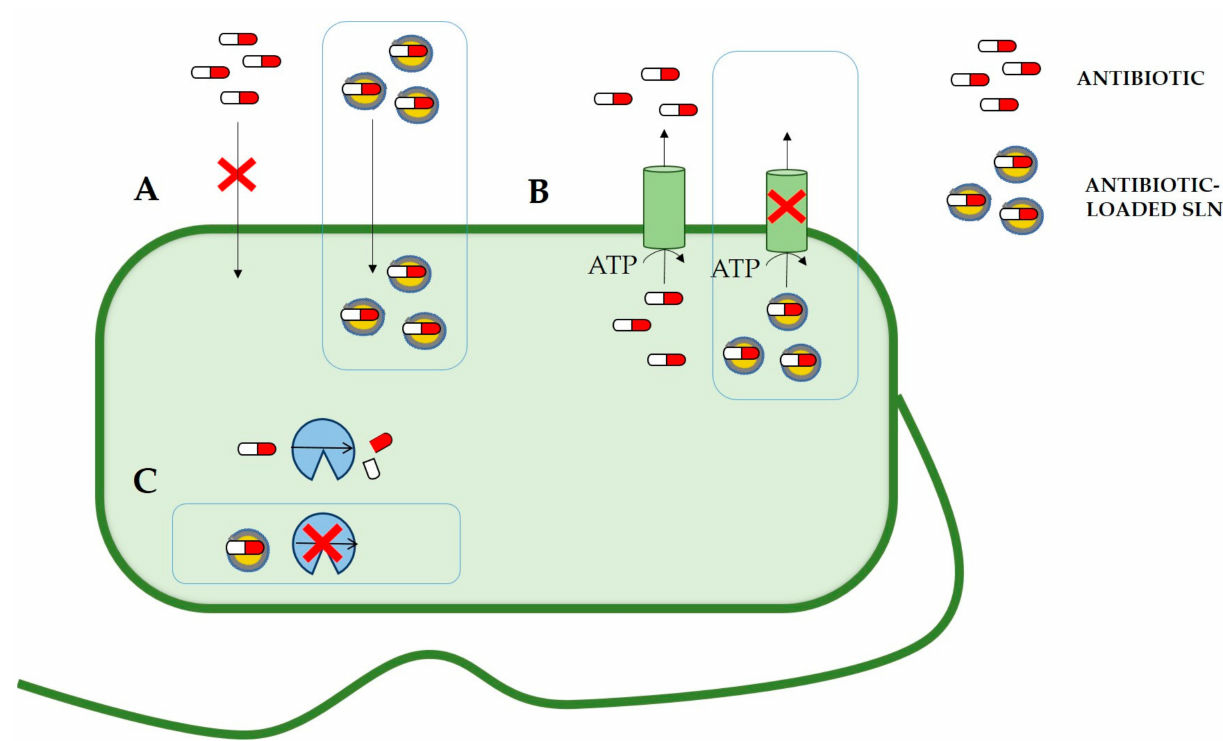
Figure 4. Schematic representation of the main antibiotic resistance mechanisms and the effect of antibiotic encapsulation into SLNs to avoid/reduce AMR mechanisms. Main antibiotic resistance mechanisms are ( A ) decreased cell wall permeability, ( B ) overexpression of efflux pumps and ( C ) antibiotic-modifying enzymes. The boxes depict ways to circumvent resistance mechanisms by incorporating antibiotics in SLNs. SLNs can ( A ) improve drug permeability, ( B ) reduce the activity of efflux pumps or ( C ) protect antibiotics from drug modifying enzymes.